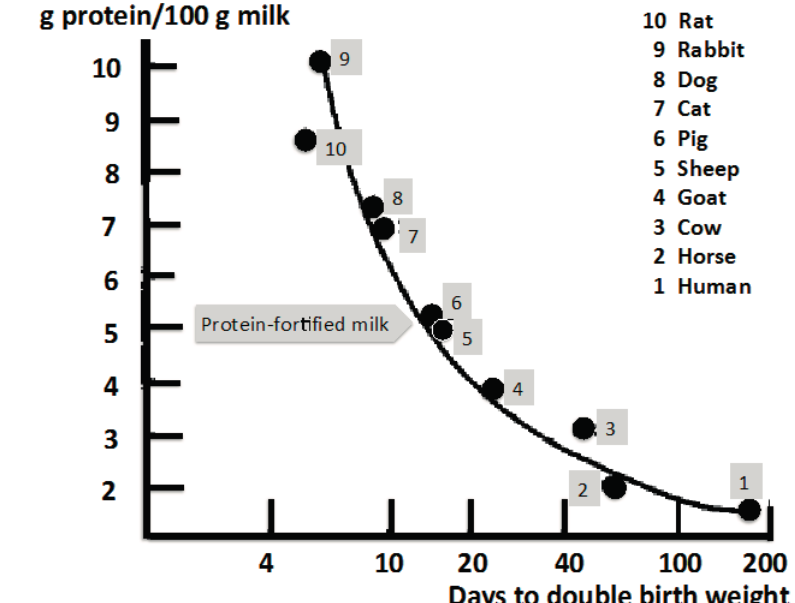
Figure 1. Interspecies comparison of time periods for doubling birth weight as a measure for the magnitude of mTORC1-dependent translation modified according to Bounous et al. [50]. Note: Human newborns (1) and other primates have the evolutionary privilege of growing on the lowest milk protein concentration (1.2 g/100 mL) thus allowing the slowest BCAA-mTORC1-driven growth, a particular advantage for complex brain